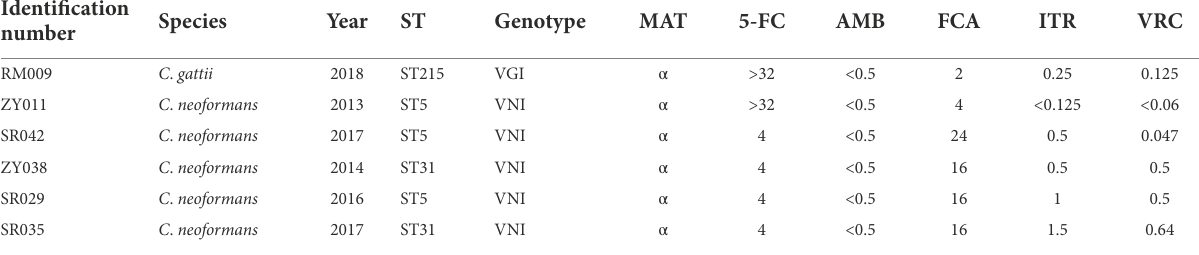
TABLE 2 General information of 6 isolates with high